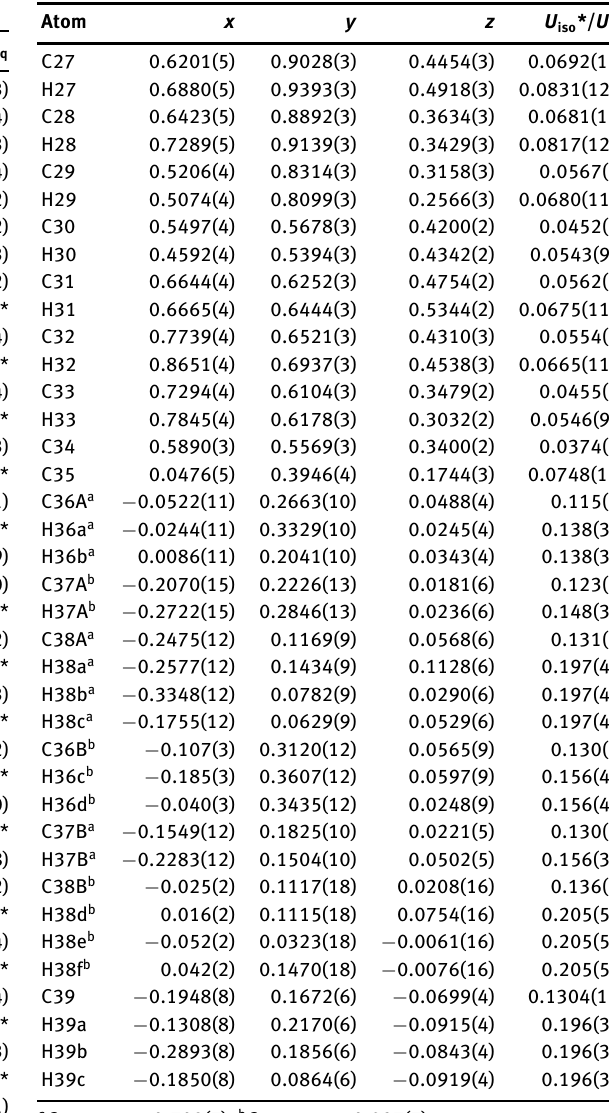
Table 2: Fractional atomic coordinates and isotropic or equivalent isotropic displacement parameters (Å 2